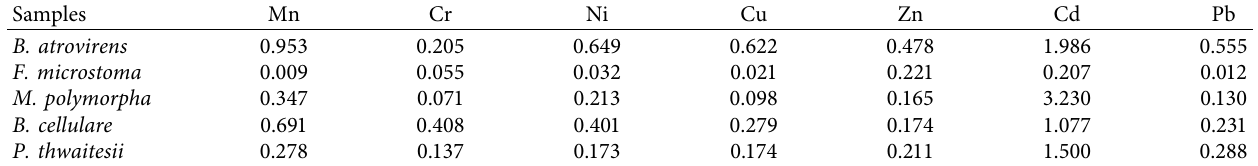
Table 11: The enrichment coefficient of heavy metals in bryophytes from electrolytic manganese slag areas. Samples Mn Cr Ni Cu Zn